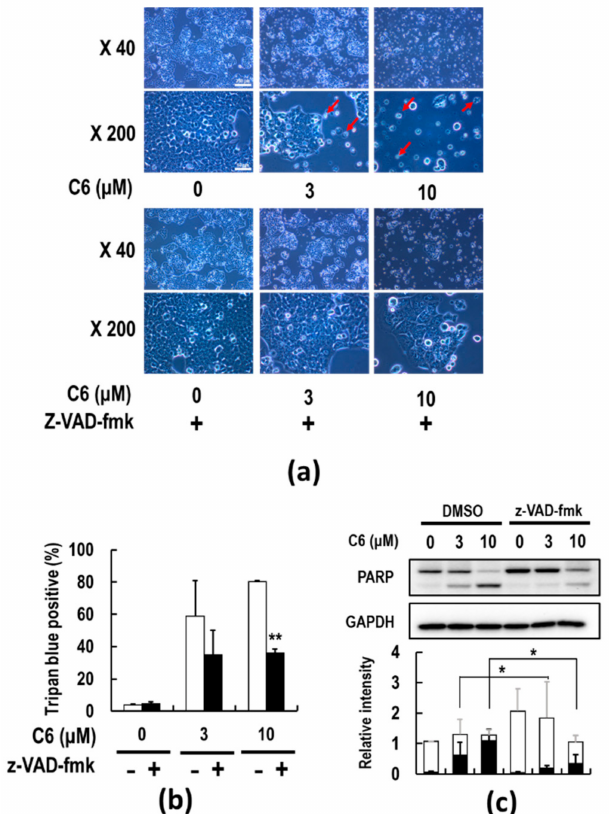
Figure 4. The effect of the pan-caspase inhibitor z-VAD-fmk on C6 -induced apoptosis. HCT116 cells were pre-treated with or without 20 µ M z-VAD-fmk for 2 h and followed by treatment with 0, 3, and 10 µ M C6 for 72 h ( a , b ) or 48 h ( c ). ( a ) Microscopic images of HCT116 cells. The arrows indicate the apoptotic cells. ( b ) Dead cells were counted by the trypan blue dye exclusion. Approximately 1000 trypan blue positive or negative cells were counted at each point. ** p < 0.01 by Student’s t -test. ( c ) Immunoblot images indicate PARP cleavage; the black and white bars represent full-length and cleaved PARP, respectively. The significance was tested by the Student’s t -test (* p < 0.05). The original image of Figure 4c is shown in Supplementary Figure